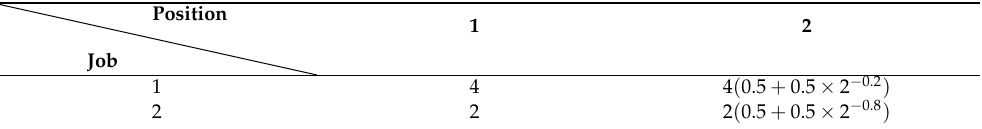
Table 2. Processing time of the group G 2 jobs in different